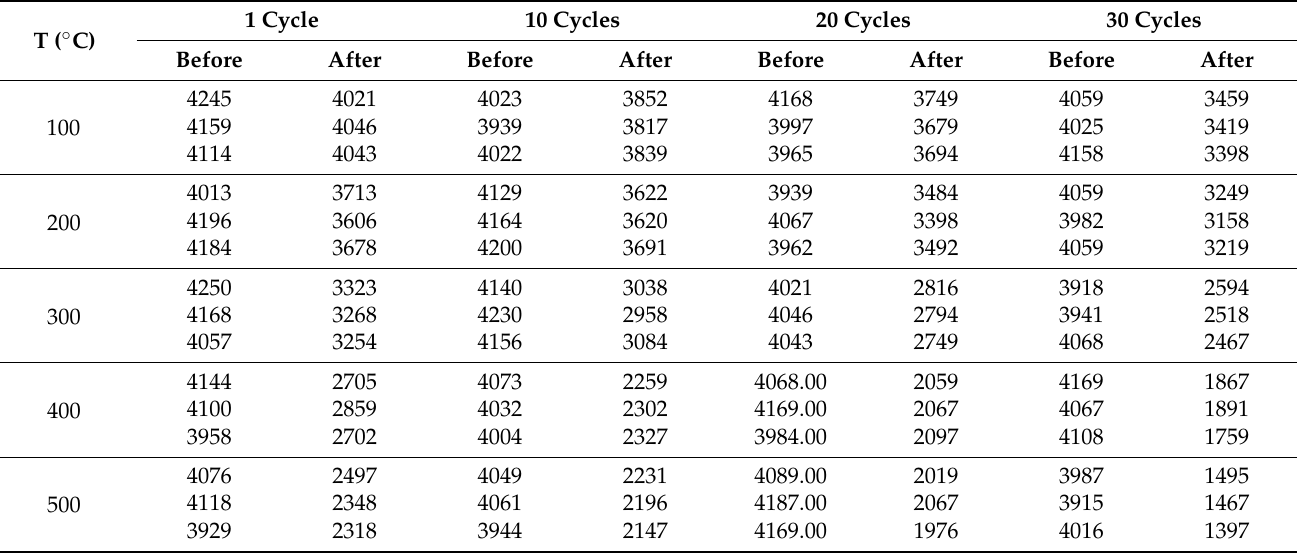
Figure 4. Ultrasonic wave propagation induced by thermal cycling treatment: ( a ) velocity of P-wave; ( b ) damage index based on P-wave. Table 2. Testing results of ultrasonic wave velocity induced by microwave